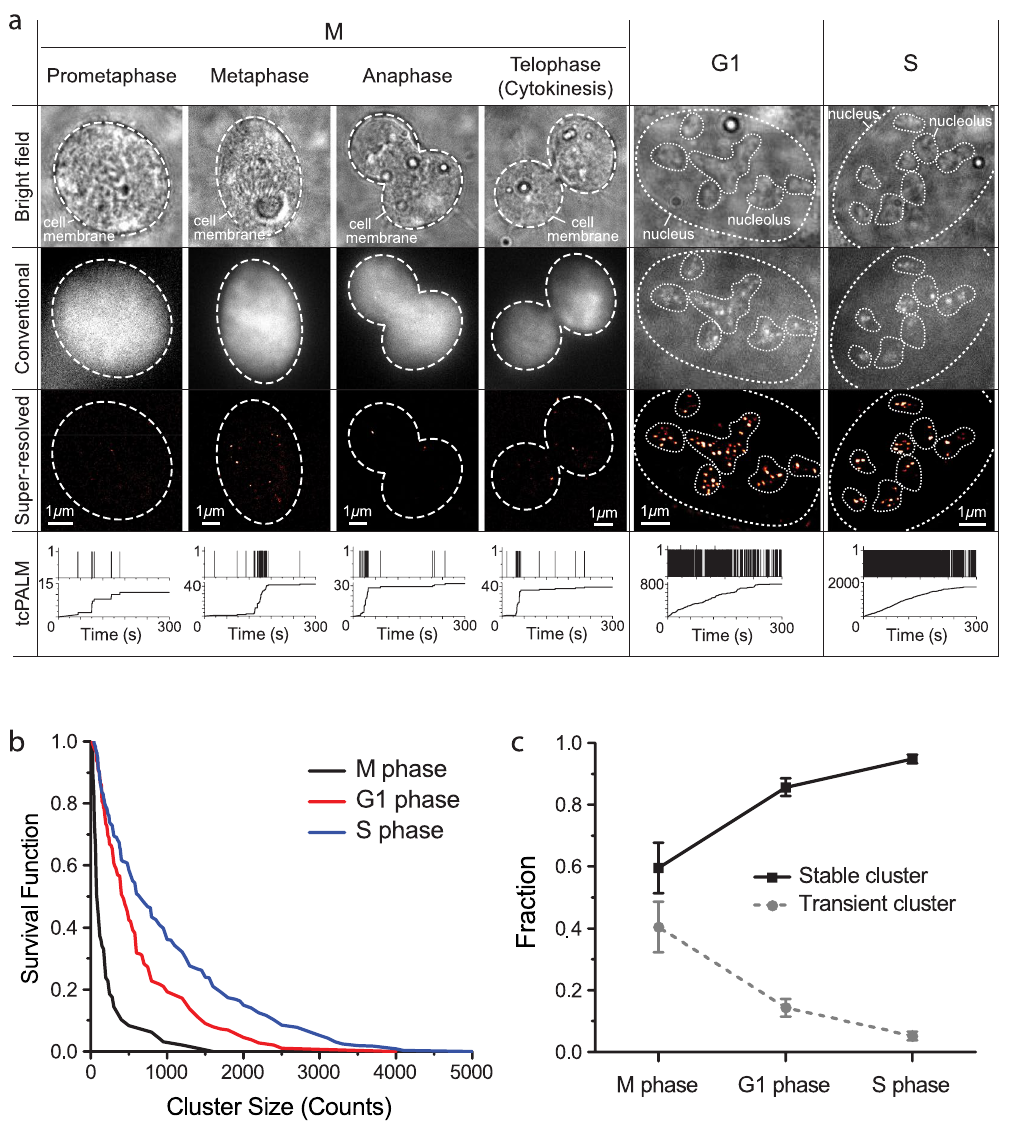
Figure 4. Cell-cycle dependent organization and dynamics of RNA Polymerase I. ( a ) Bright-field, conventional, super-resolution images and tcPALM time traces of M, G1 and S phase cells. The upper panel of the tcPALM trace represents detections per frame; the lower panel represents the cumulative detection count. Magnified tcPALM time traces are available in Supplementary Fig. S4. ( b ) Survival curve of stable cluster size in M, G1 and S phase cells. The cluster size is measured in counts, i.e., the number of localizations within the cluster. ( c ) Portion of stable and transient clusters in M, G1 and S phase cells. We imaged a total of 29 M phase cells, 30 S phase cells and 27 G1 phase cells on nine separate